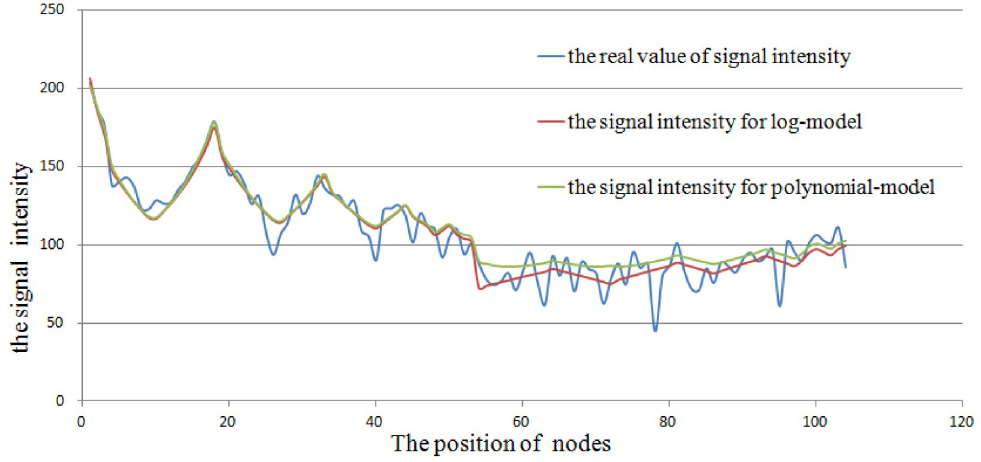
Figure 6. Fluctuation of two kinds of